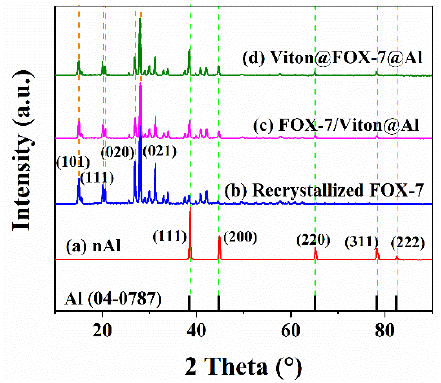
Figure 1. XRD patterns of ( a ) nAl; ( b ) recrystallized FOX-7; ( c ) FOX-7/Viton@Al and ( d ) Viton@FOX-7@Al. The XRD patterns were measured within the 2 θ range of 10°~90° at a scan speed of 0.5°·min − 1 .